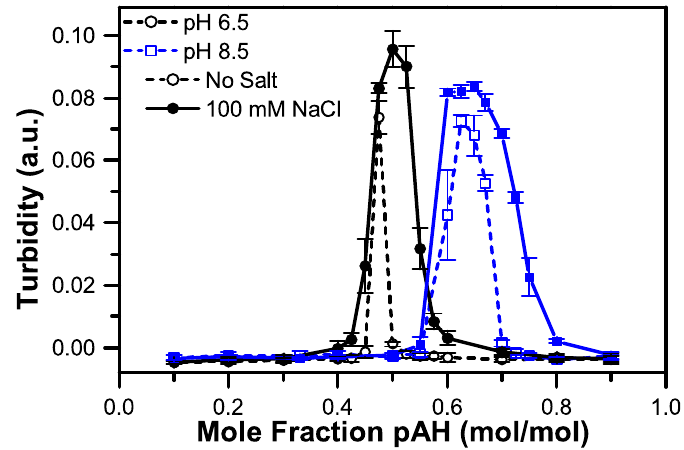
Figure 2. Plot of turbidity as a function of the mole fraction of the polycation (pAH) at pH 6.5 where both polymers are fully charged (black circles) and pH 8.5 where pAH is only half-charged (blue squares). Data are shown for conditions of no salt (open symbols) and 100 mM NaCl (closed symbols). All samples were prepared at 1 mM total monomer concentration. Complexes were prepared by adding pAA to a solution containing a mixture of pAH and the desired quantity of